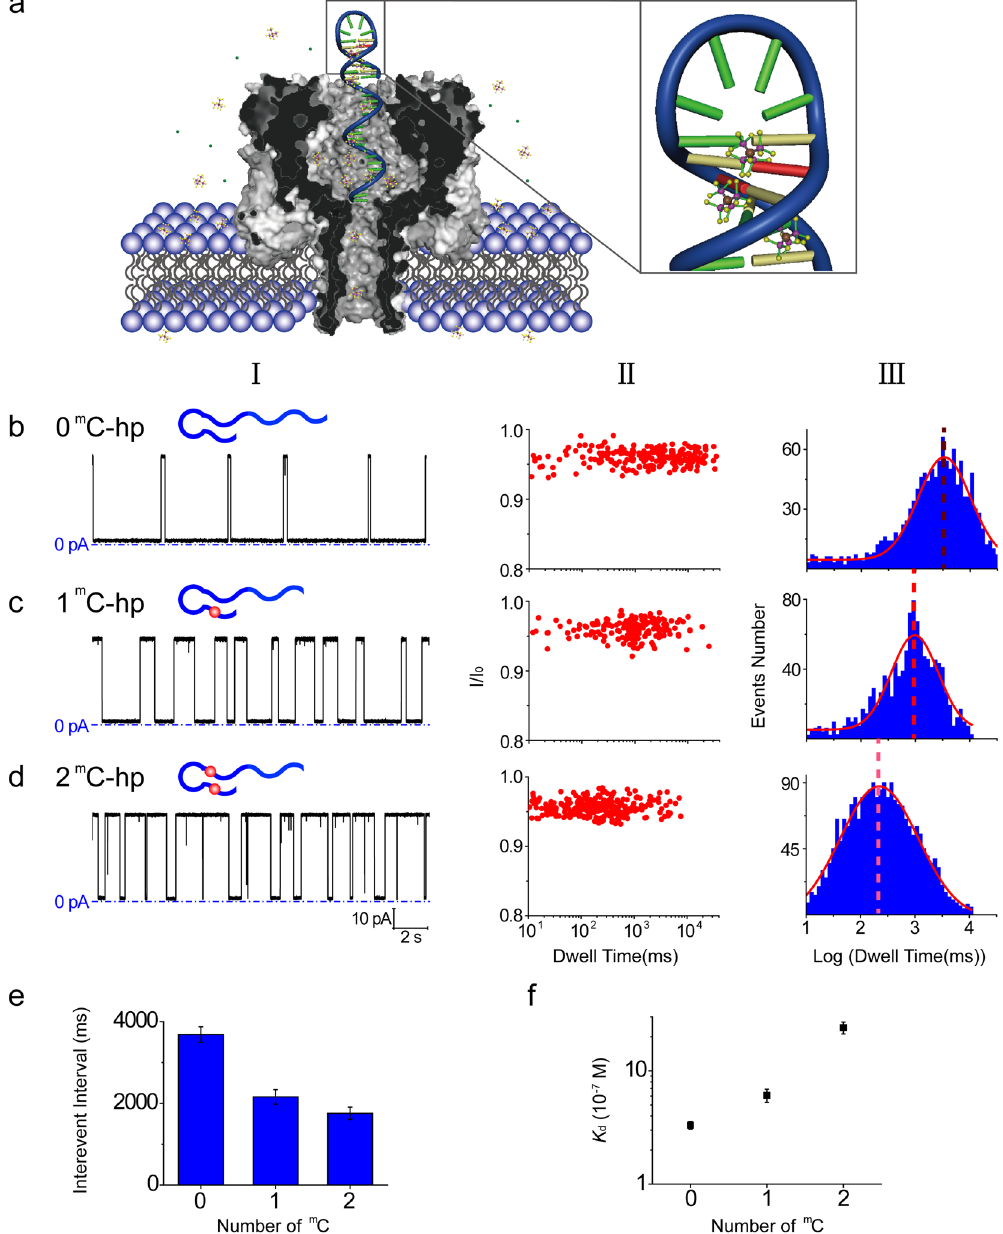
Figure 1. TMA-NP discrimination of unmethylated and methylated DNA. ( a ) Schematic of the methylated DNA hairpin containing two 5 ′ -methylcytosines (red) at duplex (2 m C-hp) translocating through the wild- type α -hemolysin ( α -HL) nanopore in 4 M TMA-Cl. ( b – d ) Representative single-channel recording traces (column I), scatter plot of I/I 0 vs dwell time (column II) and dwell time histogram in log form (column III) for unmethylated DNA (0 m C-hp) ( b ), methylated DNA containing one 5 ′ -methylcytosine (1 m C-hp) ( c ) and two 5 ′ -methylcytosines (2 m C-hp) ( d ) in 4 M TMA-Cl. 5 ′ -Methylcytosine is shown as red circles. The signals were filtered at 2 kHz and sampled at 20 kHz. Scatter plot and dwell time histograms are collected from 300 events. I/I 0 is normalized blockage current, which was obtained by dividing the average blockage current of an event by the average open channel current. The distribution of the dwell time histogram was fitted to a Gaussian function. ( e , f ) Mean interevent interval ( e ) and equilibrium dissociation constant ( K d ) ( f ) for 0 m C-hp, 1 m C-hp and 2 m C-hp. The interevent interval values were obtained from the interevent interval histograms by fitting the distributions to single exponential functions. Data points were averaged with sd from n = 6 experiments. The recordings were made at 25 °C, and the applied potential was + 40 mV (a positive potential at the trans side and the cis side at ground). DNA was added into the cis chamber with a final concentration of 0.3 µ M. The buffer was 10 mM Tris-HCl (pH